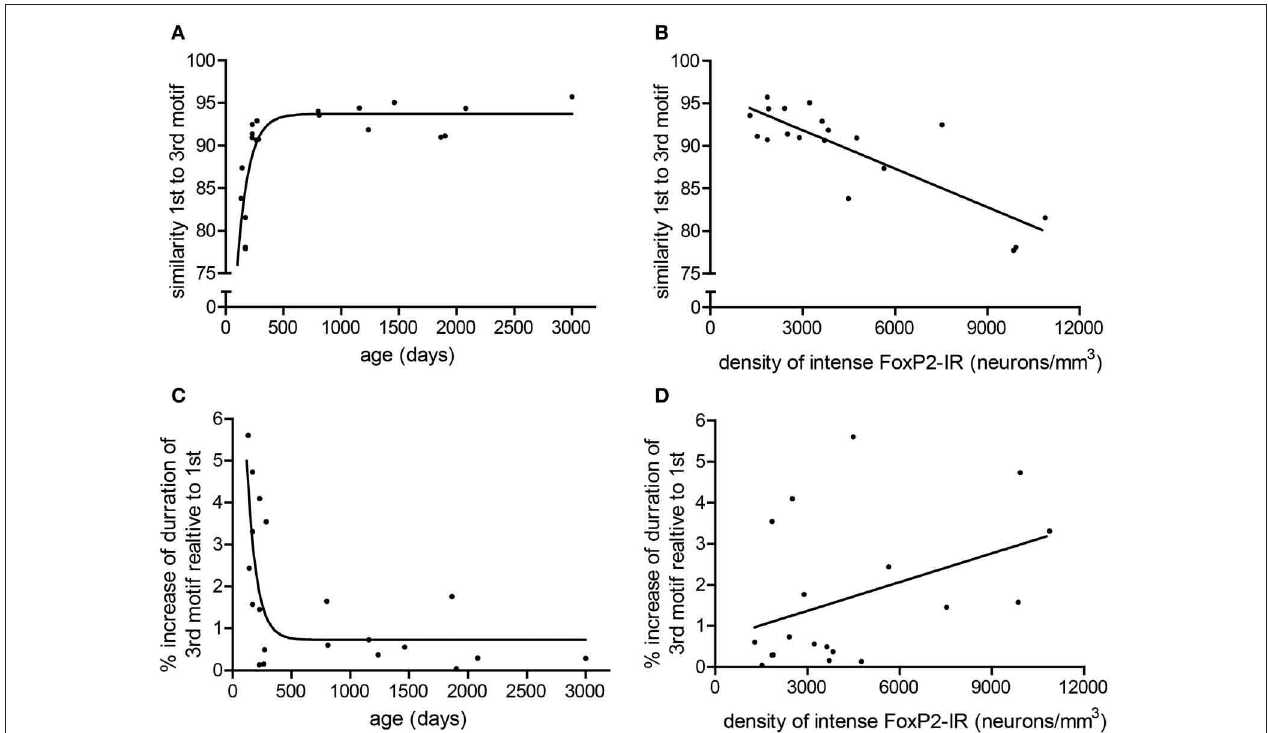
FIGURE 5 | Measures of stereotypy correlate with age and density of intensely-stained FoxP2-IR neurons. (A) The similarity of the 1st motif relative to the 3rd motif in a bout followed a one-phase association with age in adult male zebra finches ( R 2 = 0 . 641). (B) The similarity of the 1st motif relative to the 3rd motif in a bout was negatively correlated with the density of intensely-stained FoxP2-IR neurons in Area X ( R 2 = 0 . 7131,